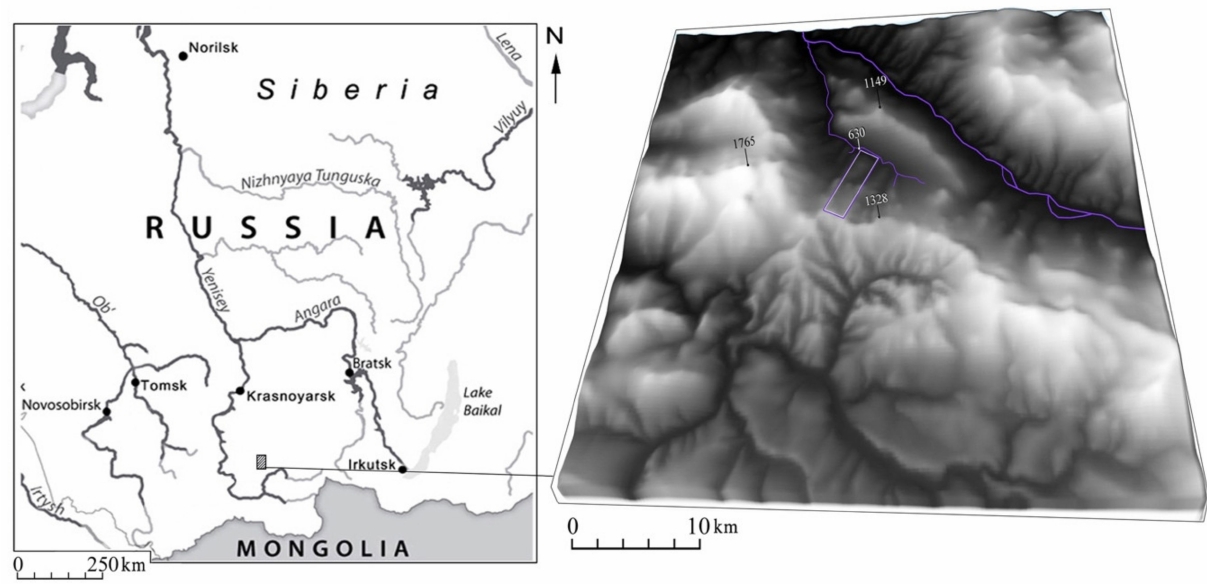
Figure 6. The geographical location of the study area.